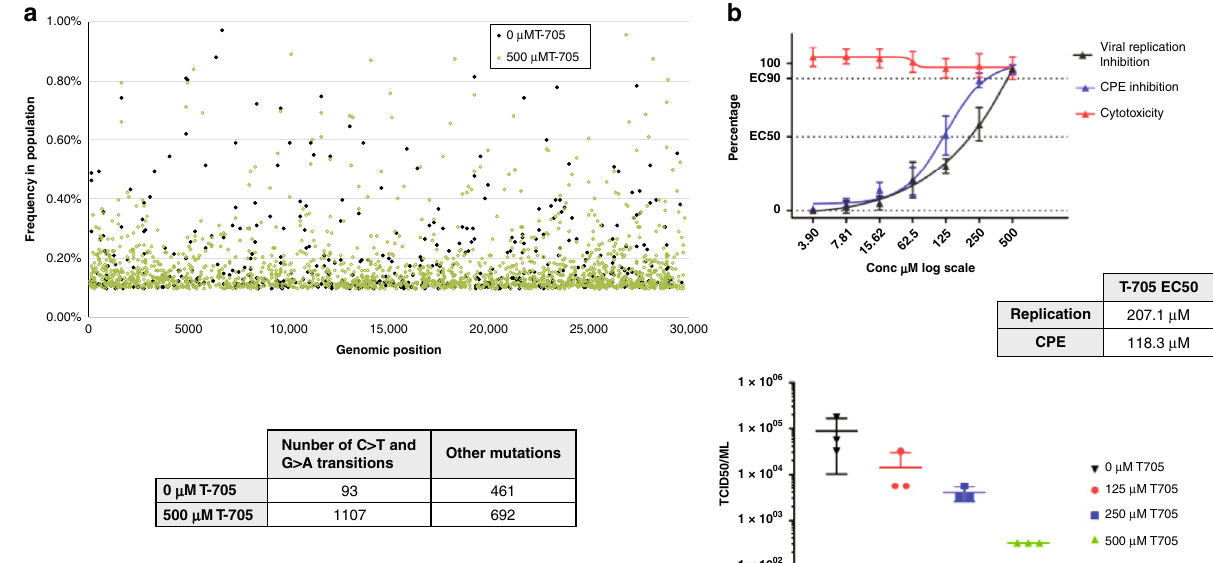
Fig. 1 Antiviral effects of T-705 on SARS-CoV-2. a In vitro effects of T-705 on SARS-CoV-2. Distribution of the mutations along the SARS-CoV-2 genome and number of mutations observed in presence or absence of T-705. A 3-fold increase in the presence of the drug is observed ( P < 0.001, Pearson ’ s χ 2 test with Yates ’ continuity correction). b Quanti fi cation of the antiviral effect of T-705 by genome copy number, virus-mediated CPE and number of infectious particles. Mean ± standard deviation (SD) shown ( n = 3). Source data are provided as a Source Data fi le.